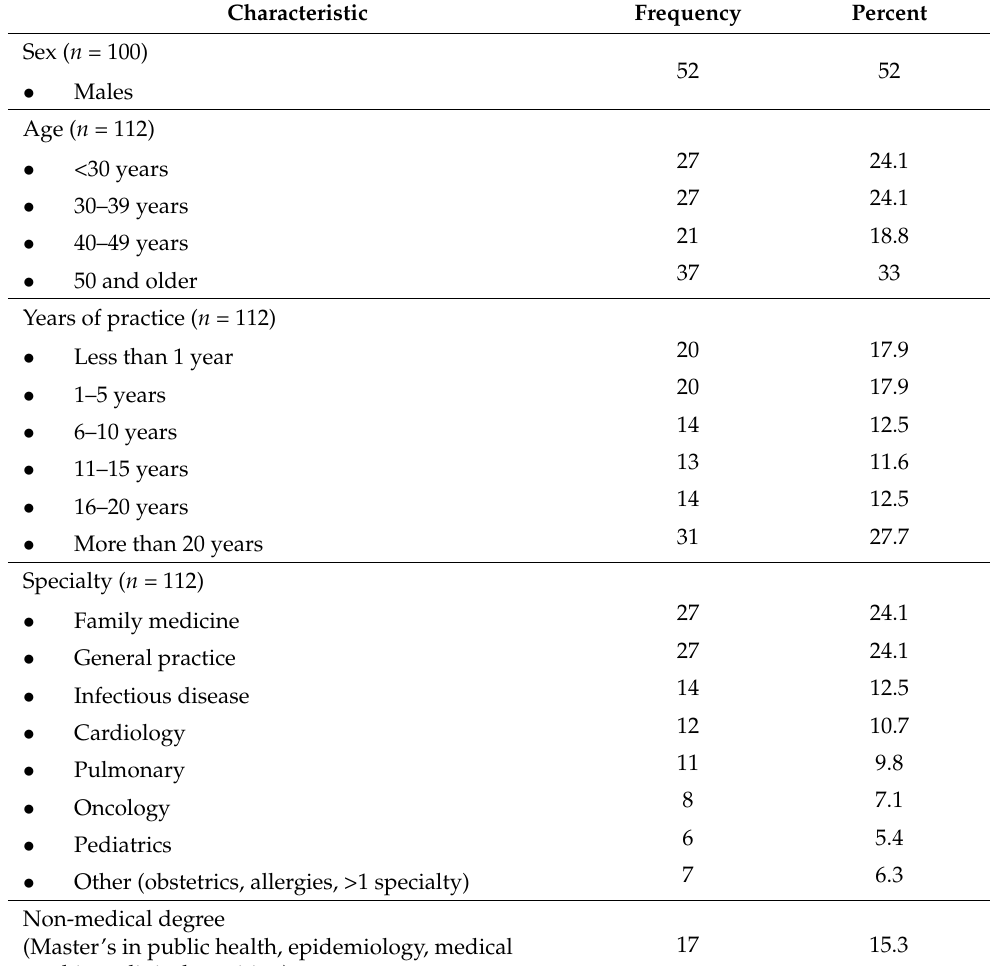
Table 1. Demographic characteristics of the sample ( n =